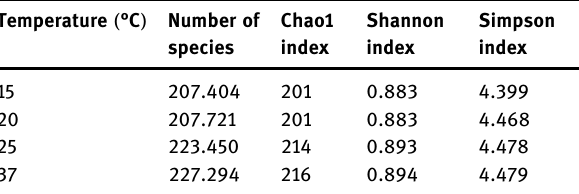
Table 4: Changes in the archaea diversity index in the anaerobic digestion system of cattle manure at sub - mesophilic temperatures Temperature ( °C ) Number of